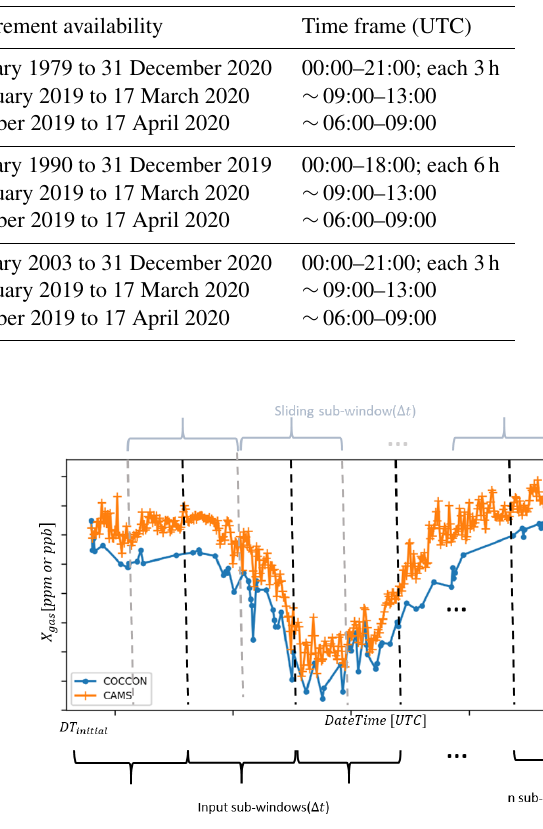
Figure 15. Principle of the scaling method. Sub-windows are sep- arated with black dotted lines and sliding sub-windows with grey dotted lines. The window size ( (cid:49)t ) is defined in Eq.